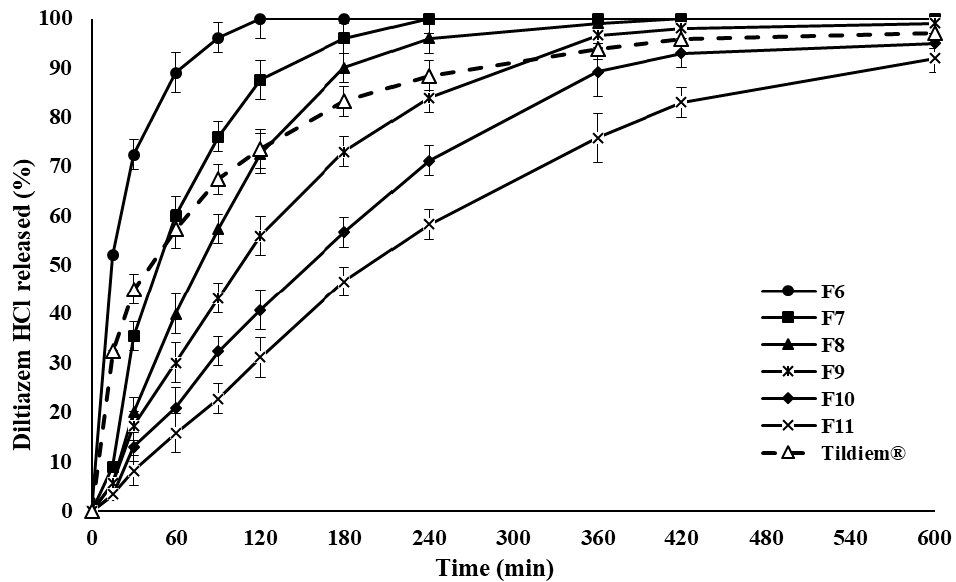
Figure 3. The rate of DLZ controlled release from polymer matrices containing constant amount of drug and various polymer mixture percentages and Tildiem ® over 600 min, using distilled water at 37 °C, values are means ± S.D. ( n = 6). Table 2. Controlled release polymer matrices containing various drug to polymer percentages with the addition of HPMC and STA.